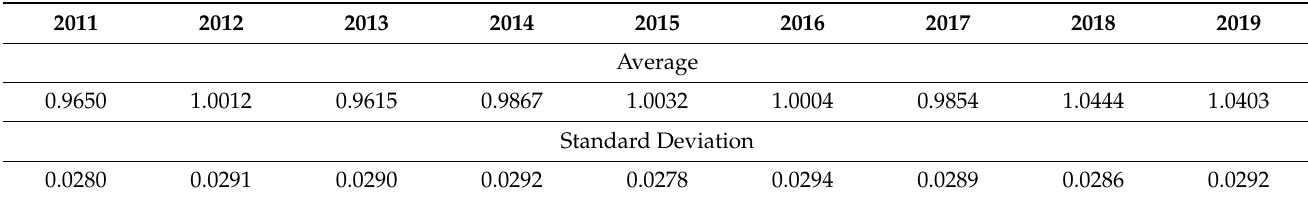
Table 2. Trend of Green Productivity Indices in Different Regions across China